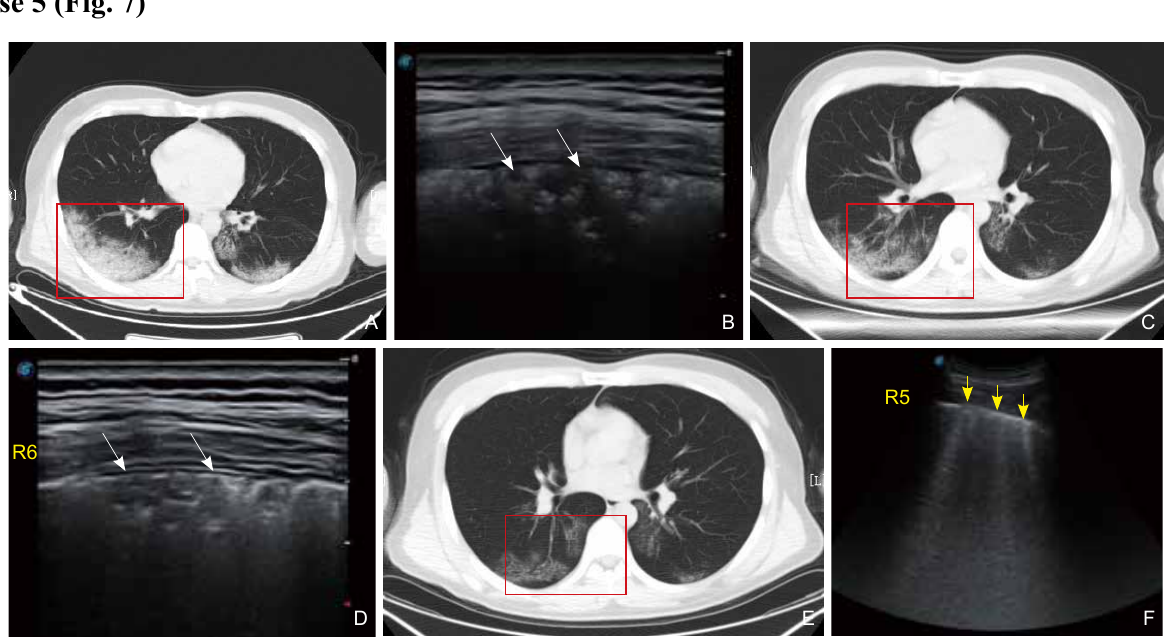
Figure 7 A 33-year-old male, progressive stage (A, B) and recovery stage (C, D, E, F). He had a fluctuating fever (ranging from 37.4 to 38.8℃) for 12 days, diarrhea for 8 days, and intermittent cough with phlegm prior to the admission. The novel coronavirus nucleic acid test was positive. At the progressive stage, the chest CT (A) showed large subpleural soft tissue shadows at the right lower lobe. The corresponding pleural line was discontinuous (arrow) with subpleural consolidation and air bronchogram signs. The recovery stage CT showed that the consolidation of bilateral lungs was gradually absorbed (Compared with A). The recovery stage ultrasound (D) showed the lesions were reduced with an increased hyperechogenic gas in the consolidation (arrow). Later, lesions disappeared with a small amount of B-lines remaining